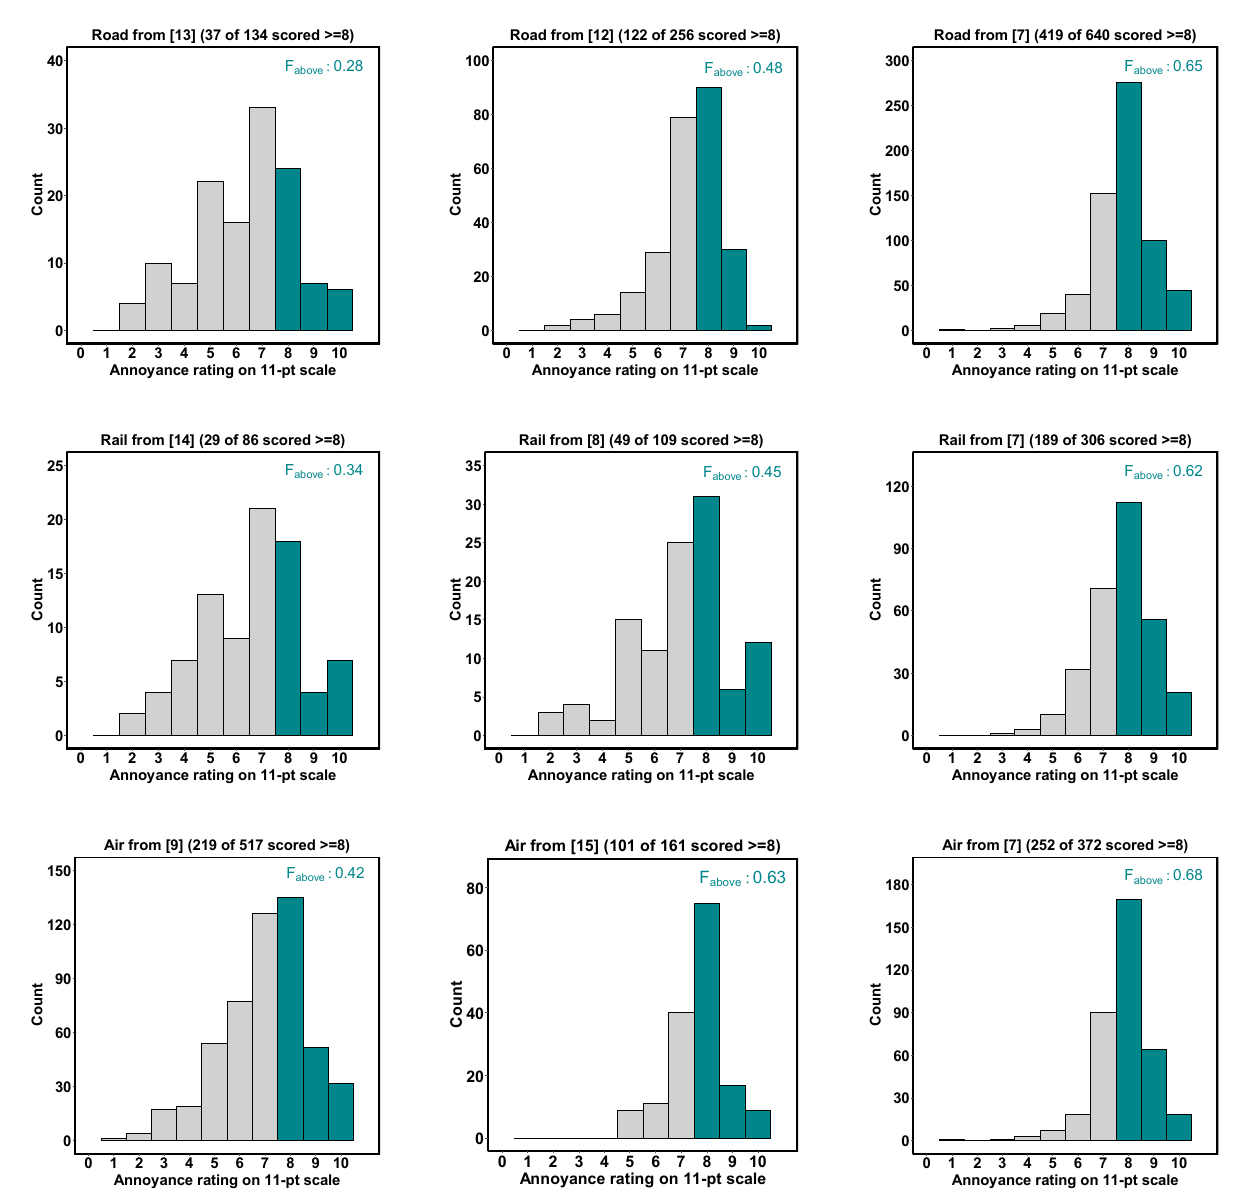
Figure 4. Distribution of responses on the 11-point scale of respondents that chose “very” (numerical value 3) on the 5-point scale in studies on road traffic, railway, and aircraft noise, with the fraction above the cutoff point of 72.73% in dark green. Data sources are from the following studies: [7–9,12–15].